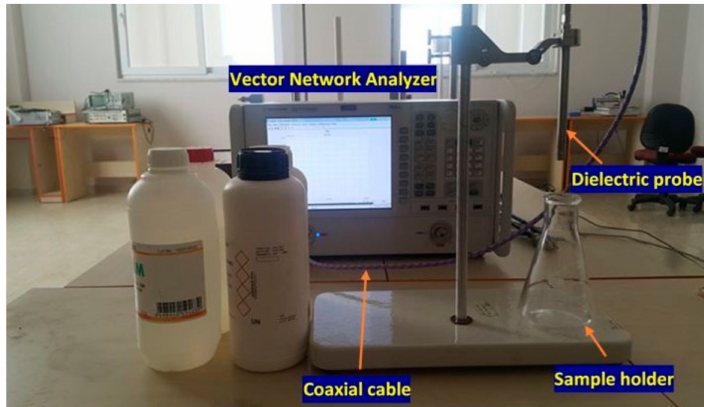
Figure 7. Experimental setup to determine dielectric measurement of the chemical samples by 85070E dielectric probe